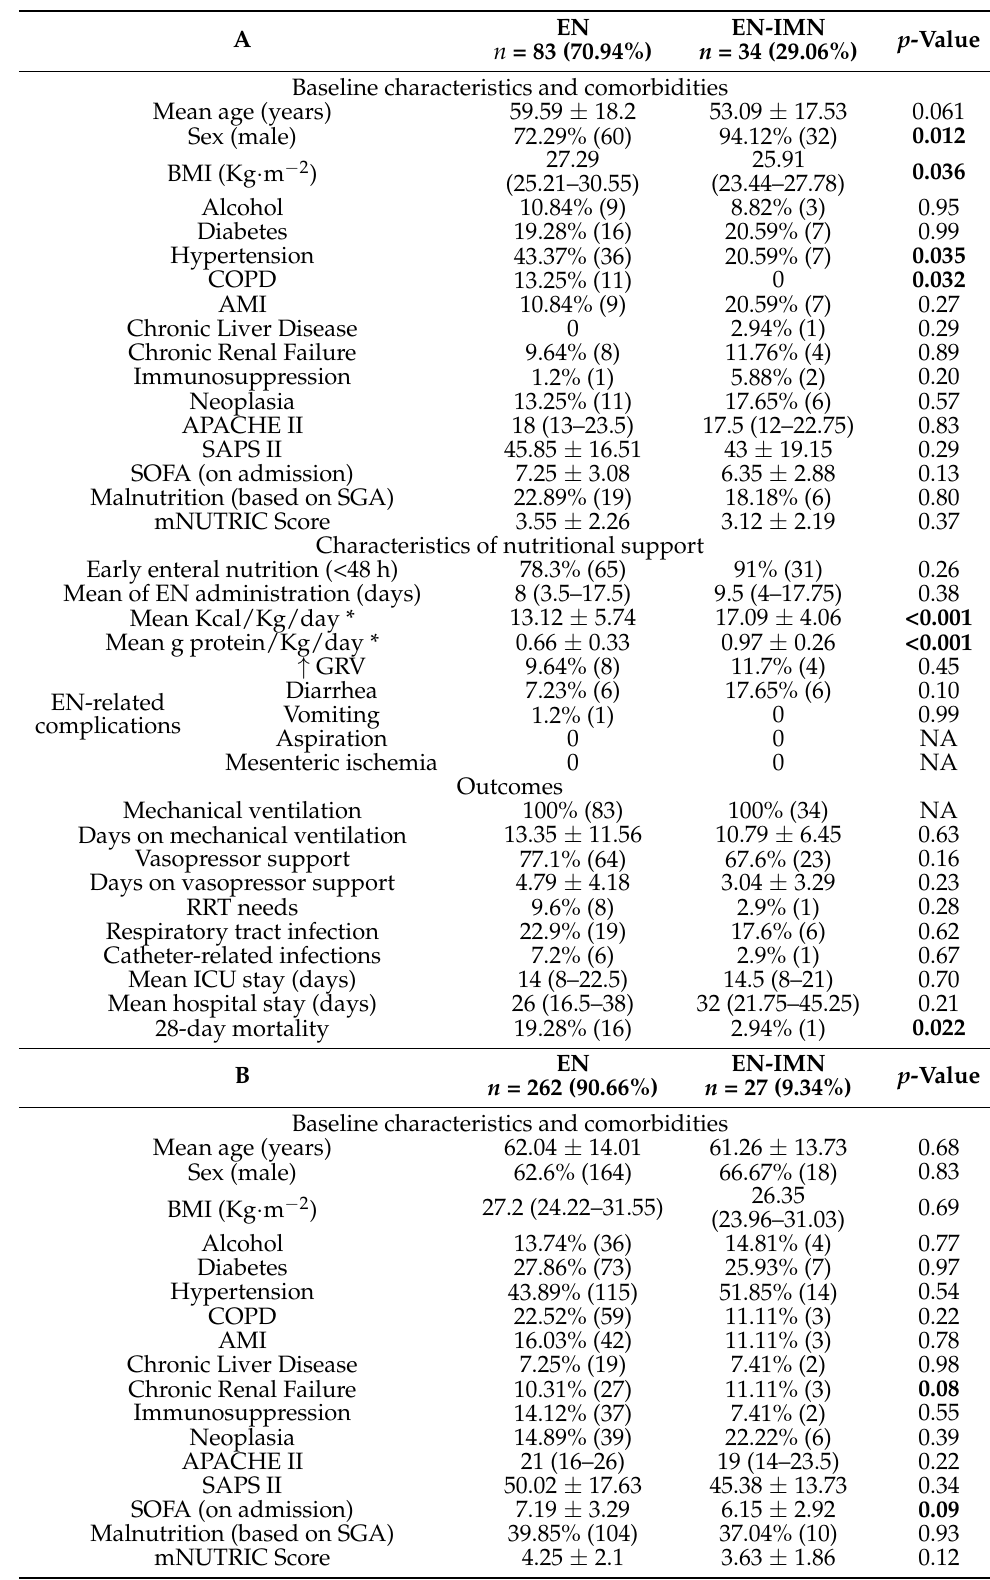
Table 5. Differences among patients receiving immunonutrition formulas and other types of enteral formulas in trauma and surgical ( A ) and medical ( B )